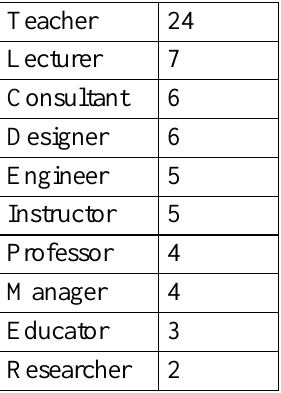
Table 3 The Most Common Occupations